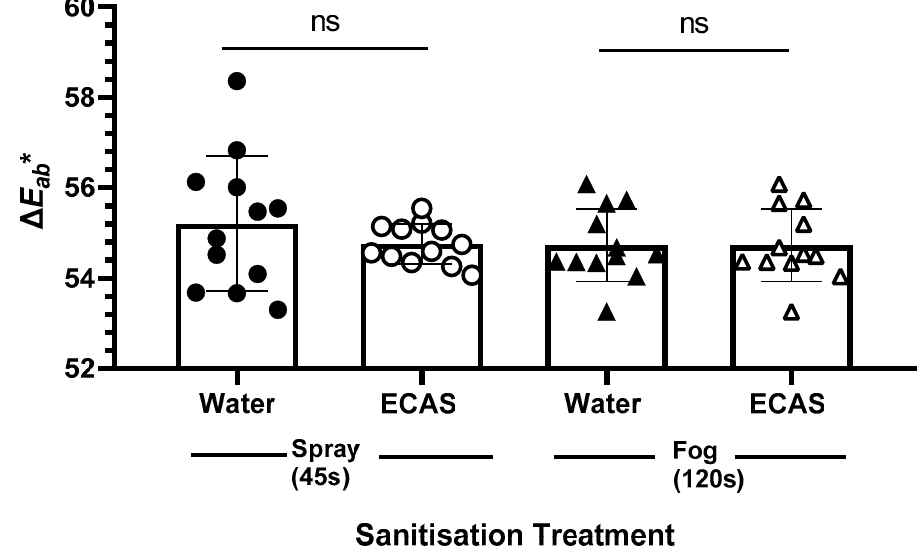
Figure 3. Effect of sprayed and aerosolised ECAS treatments on cuticle integrity ( Δ E ab* ). Data presented as mean ± SD, n = 12; ns—not